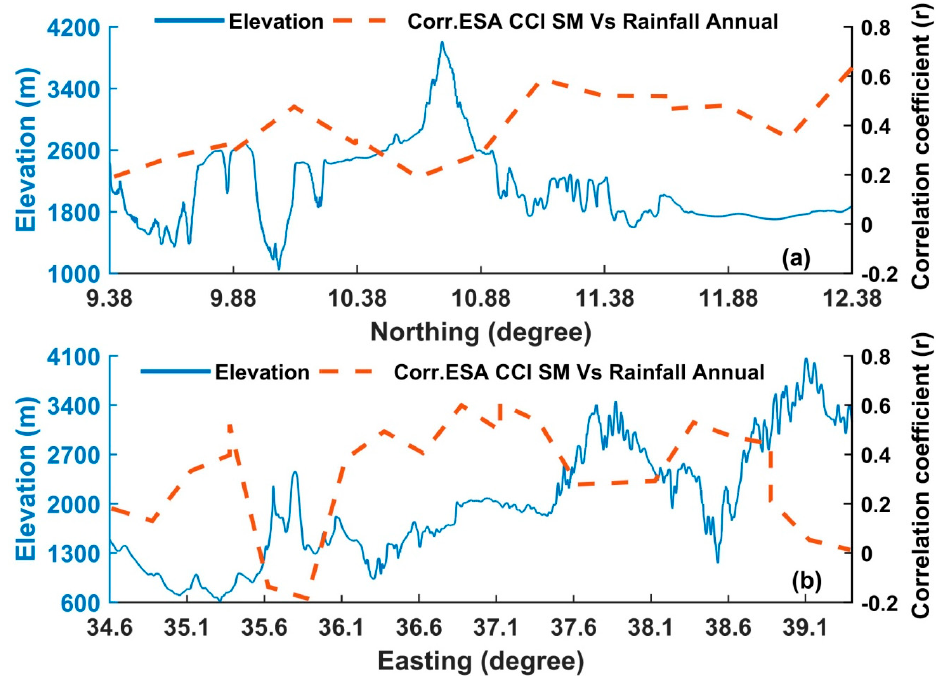
Figure 12. The correlation between autumn soil moisture (ASM) and annual rainfall along transects from ( a ) from north to south-east and ( b ) from west to east (WE) (1992 to 2017). The degrees to which land cover types affect the correlation between ASM and rainfall could vary with vegetation type, density, and seasons. Table 3 shows the results of the spatial correlation between ASM and rainfall over the dominant land cover classes of the basin. The correlation between ASM and rainfall respond distinctively across the different seasons and land cover classes. For example, the highest correlation between ASM and spring rainfall was observed over the forestland (r = 0.51); however, autumn (r = 0.19) and summer (r = − 0.28) rainfall showed their lowest positive and highest negative correlation in forestland, respectively. Table 3. The correlation between ASM and rainfall over the major land use land cover classes of the UBNB. LULC Type